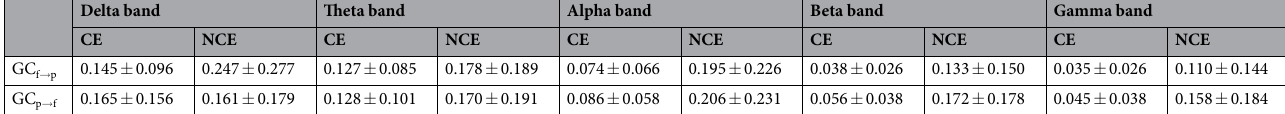
Table 2. Directionality in CE and NCE based on Granger causality. Frontal-to-parietal GC connectivity and parietal-to-frontal GC connectivity in all frequency bands are described. Data are presented as mean Granger causality ± standard deviation. GC f → p = frontal-to-parietal directionality of Granger causality; GC p → f = parietal- to-frontal directionality of Granger causality; CE = conscious experience; NCE = no conscious experience.